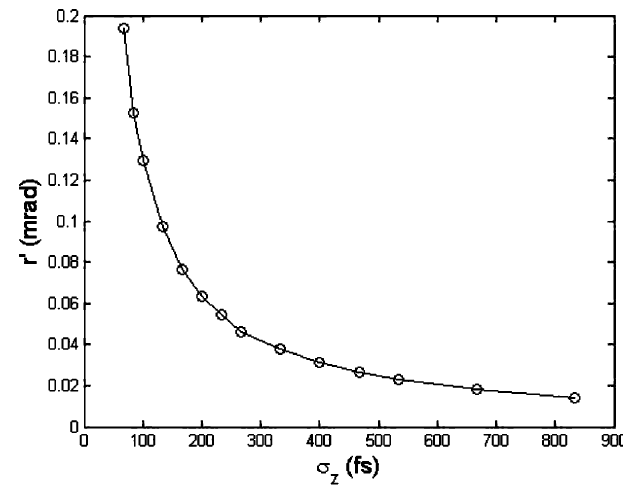
FIG. 3. DR Deflection of high-energy beam with various bunch